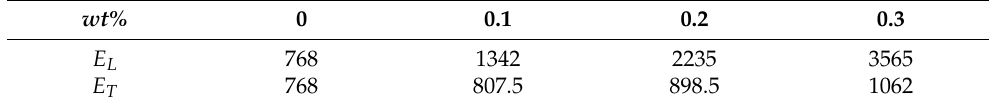
Table 3. Young’s modulus in longitudinal and transverse